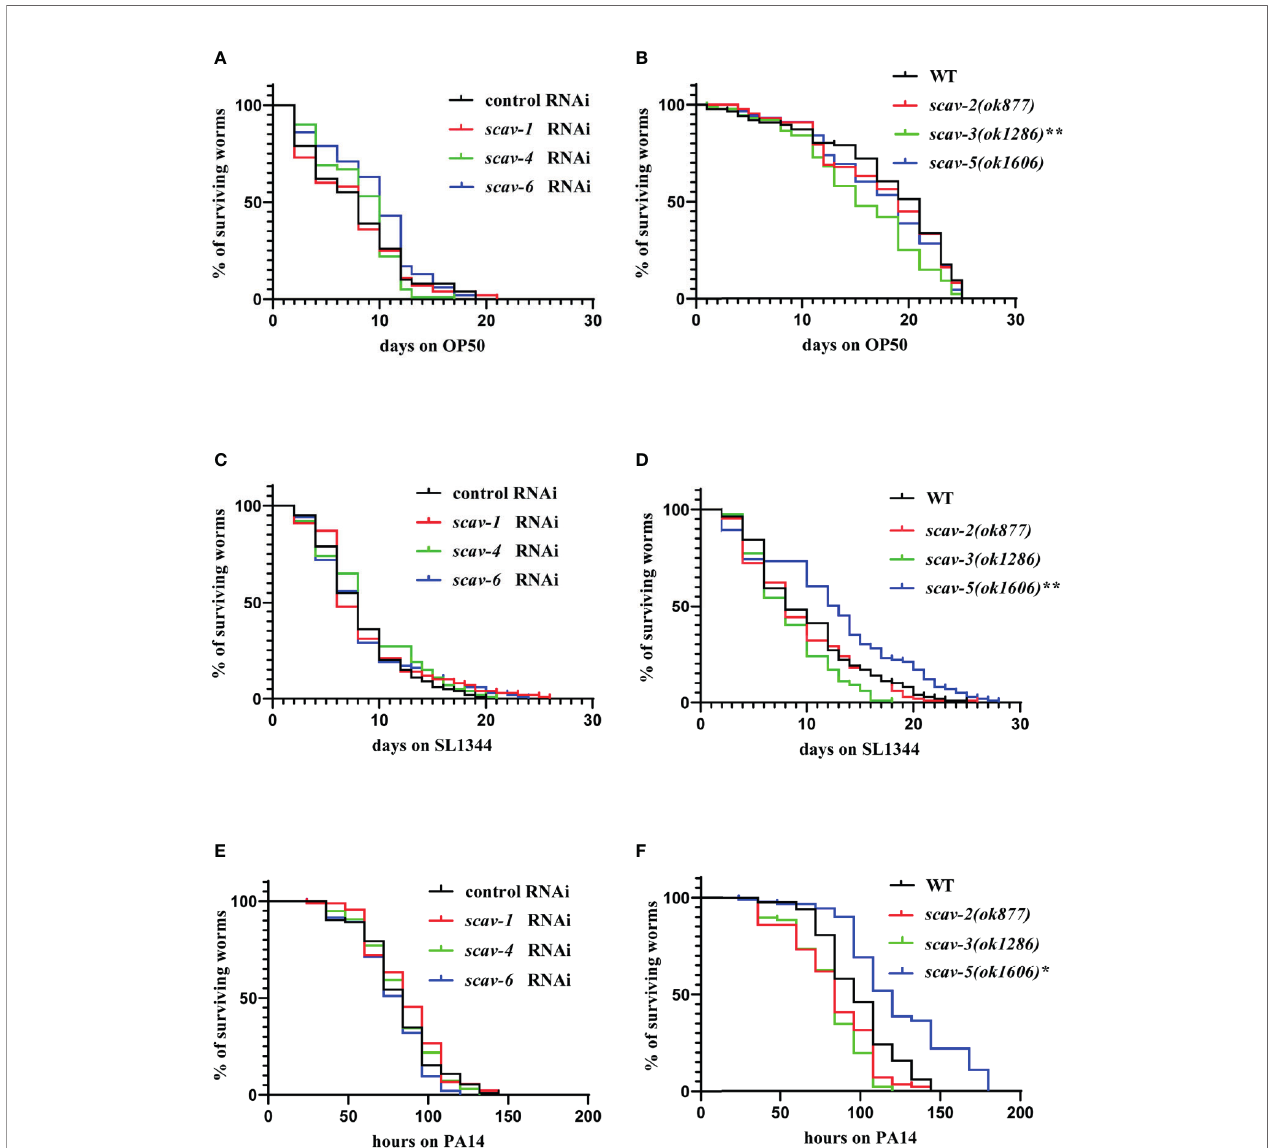
FIGURE 2 | scav-5 mutants are resistant to S. typhimurium SL1344 and P . aeruginosa PA14. (A, B) The lifespan of wild type with scav-1 , scav-4 , scav-6 RNAi (A) and scav-2 , scav-3 , scav-5 mutants (B) fed on E. coli OP50. (C, D) The scav-5(ok1606) mutation signi fi cantly extended the lifespan of otherwise wild type, scav-1 , scav-4 , scav-6 RNAi (C) and scav-2(ok877) , scav-3(ok1286) mutants (D) fed on S. typhimurium SL1344. (P < 0.01) (E, F) The scav-5(ok1606) mutation signi fi cantly extended the lifespan of otherwise wild type, scav-1 , scav-4 , scav-6 RNAi (E) and scav-2(ok877) , scav-3(ok1286) mutants (F) fed on P. aeruginosa PA14. (P <